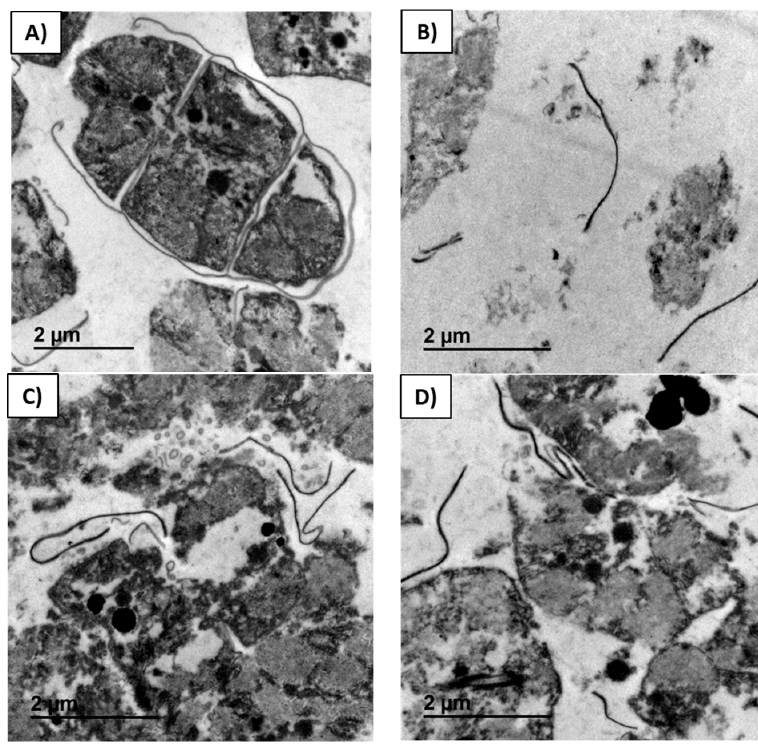
Figure 5. Transmission electron microscope (TEM) micrographs of residual biomasses of Arthrospira p. , obtained after the control extraction ( A ) and the extractions with Alcalase ® ( B ), Ultraflo ® ( C ), and Vinoflow ® ( D ) pre-treatments. Extracts were obtained in their optimal conditions (pH 6.5, 1% v/w Alcalase ® and 30 °C; pH 7.0, 1% v/w Ultraflo ® and 30 °C; pH 6.5, 2% v/w Vinoflow ® and 40 °C), and